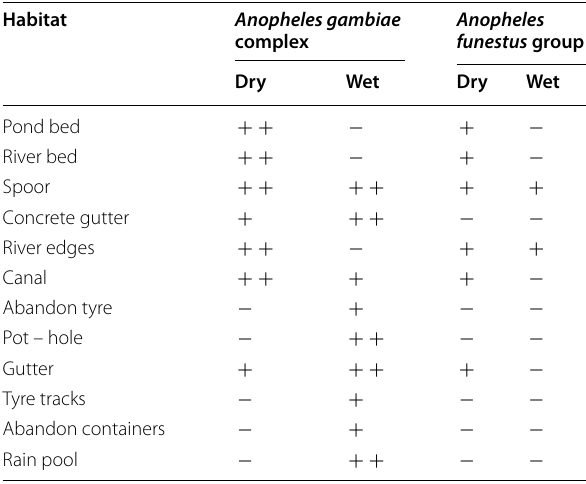
Table 2 Habitat preference and seasonal variations of Anopheles mosquitoes larvae and pupae in the study area (750 ml of water per